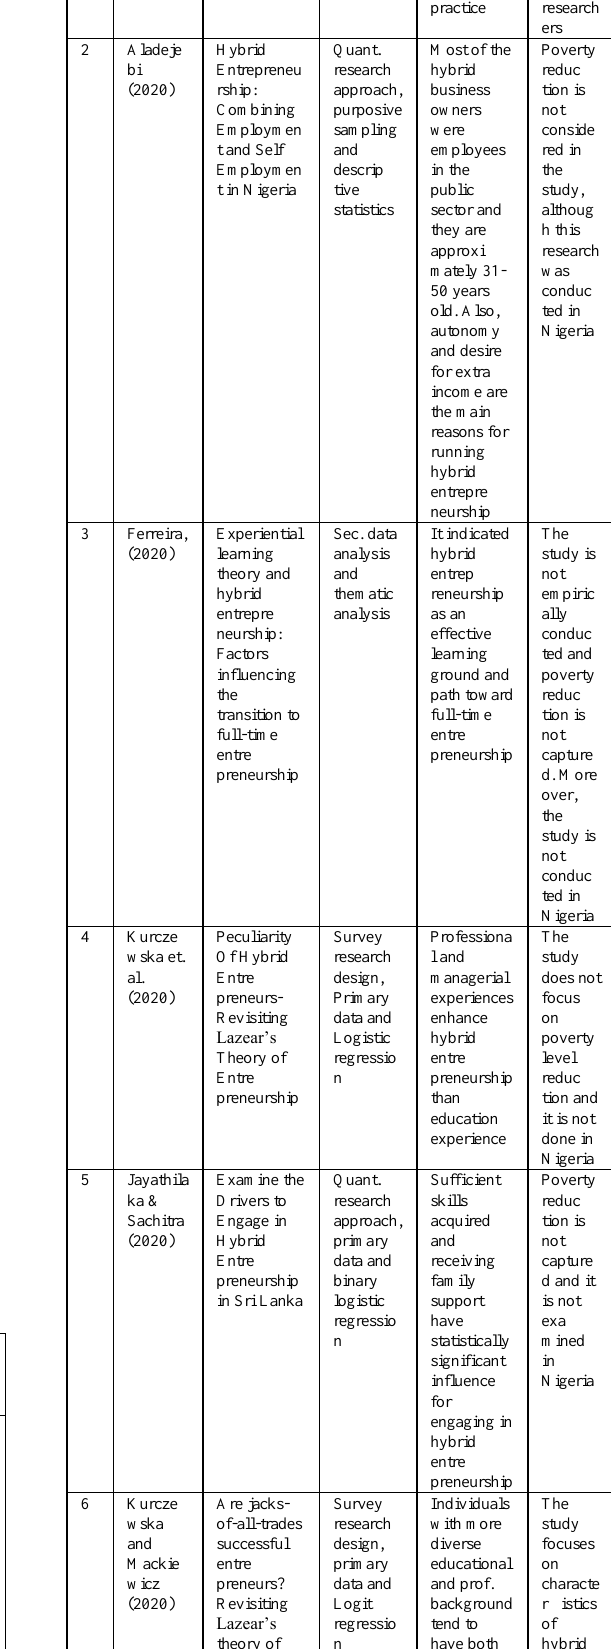
characte r istics of